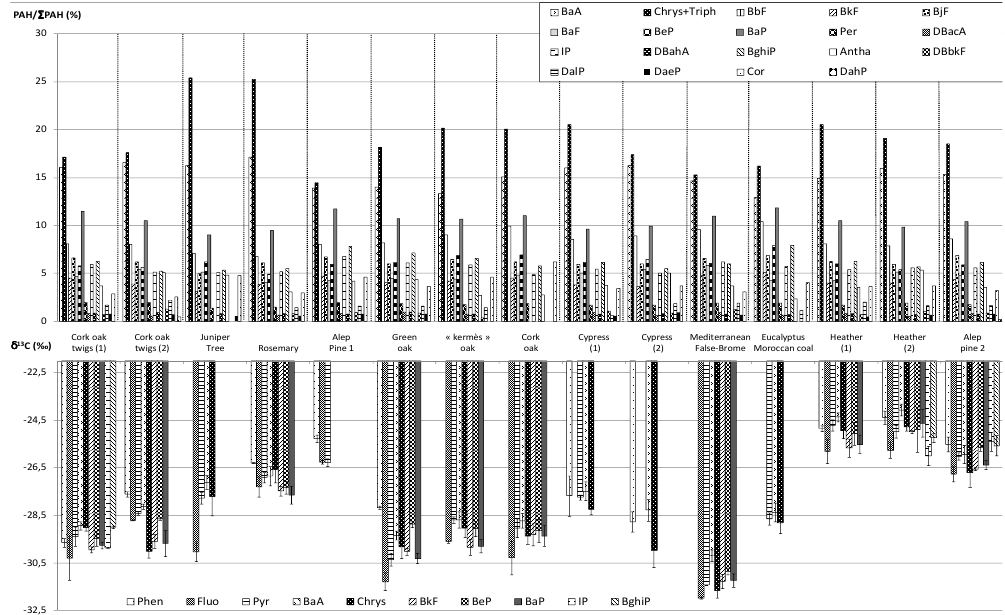
Fig. 3. Stable-carbon isotopic compositions of particulate-PAHs from different wood combustions compared with their molecular finger-